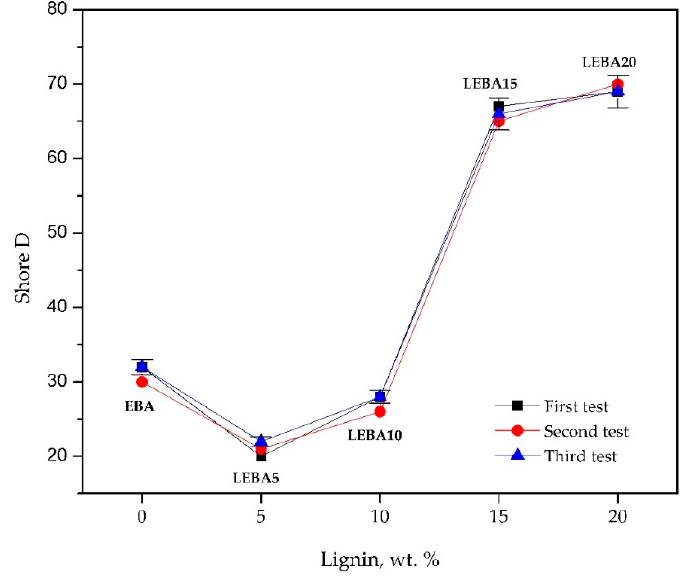
Figure 8. Shore D hardness vs. lignin wt.% .